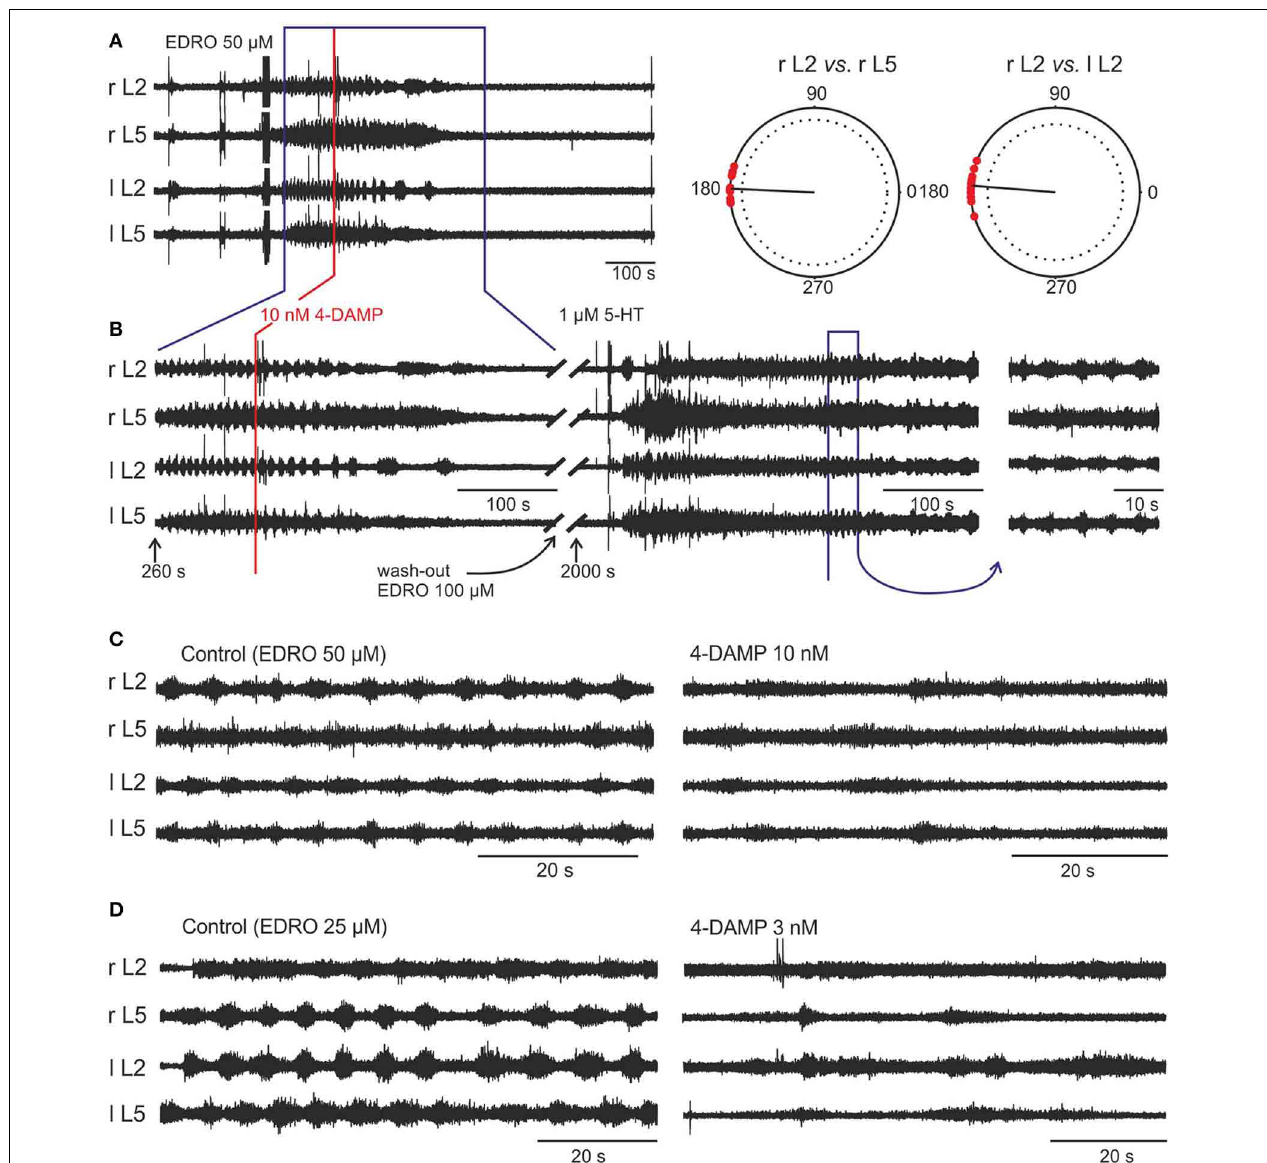
FIGURE 4 | EDRO-induced locomotion is blocked by 4-DAMP. (A) 50 μ M EDRO induced a sustained pattern of locomotion. (A , right panel ) Polar Plots of flexor-extensor and left/right alternation show highly coordinated locomotion prior to the application of 4-DAMP. (B) 4-DAMP applied to the bath decreased rhythm frequency from 0.178 to 0.063Hz followed by complete blockade of rhythmic activity. An additional dose of EDRO (100 μ M) failed to induce locomotion (data not shown), but adding 1 μ M 5-HT to the